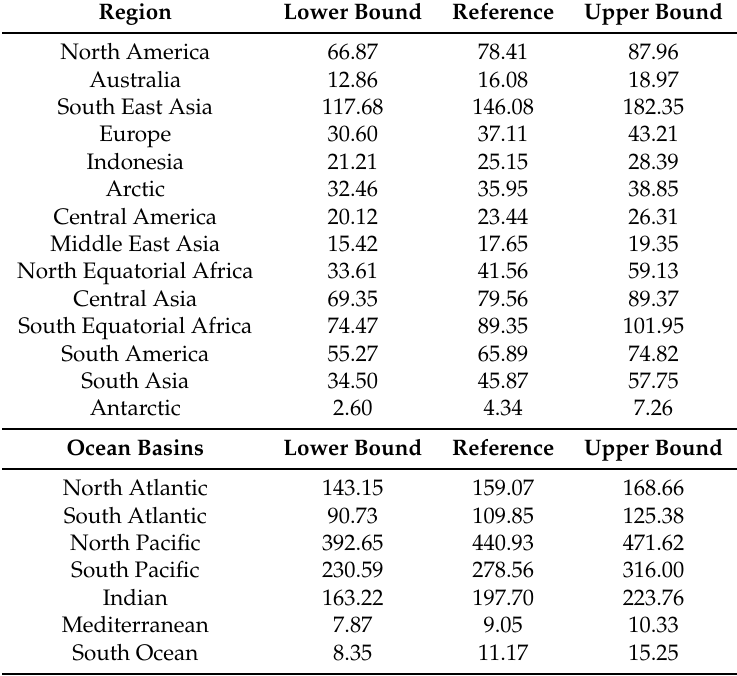
Table 3. Reference (BASE), and upper and lower bound (95% level) for the mean of the Hg deposition (Mg/year) for each receptor region originating from all source